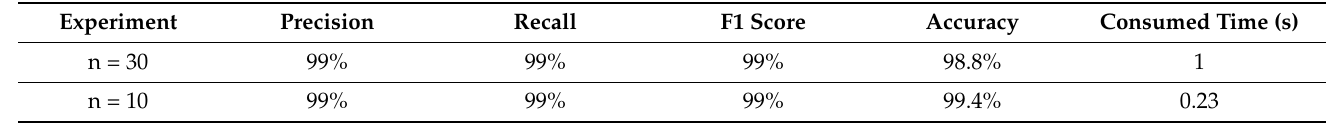
Table 4. The Results of Choosing the Best Number of Features for the PCA Classifier.